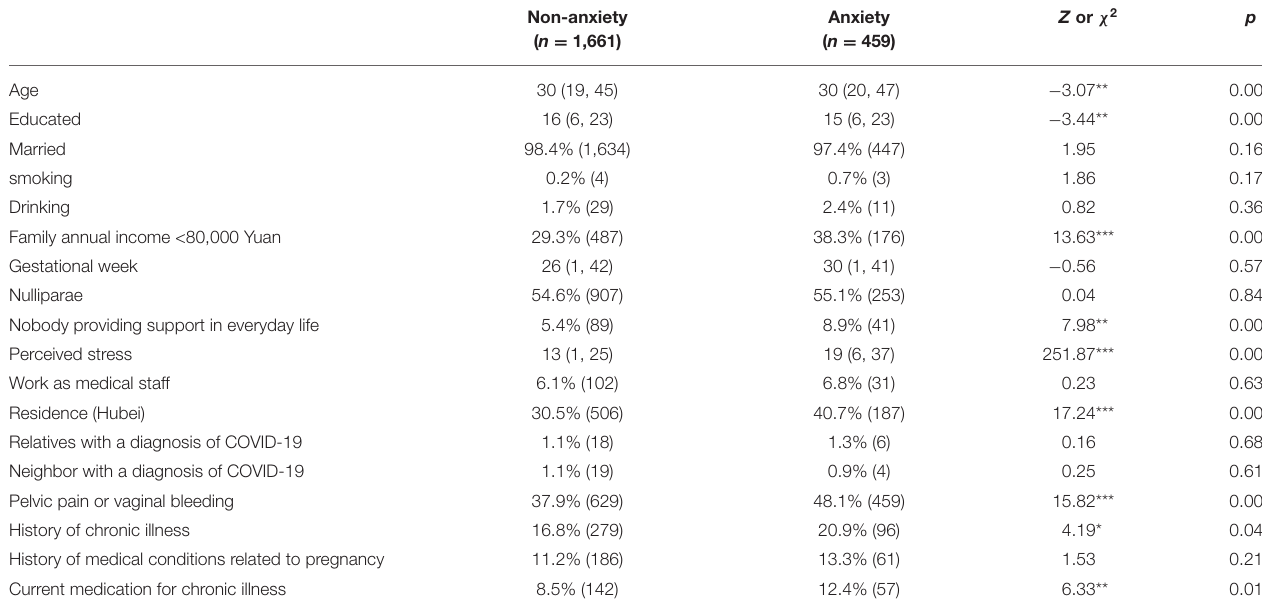
TABLE 1 | Comparison of COVID-19-related factors between the participants with and without